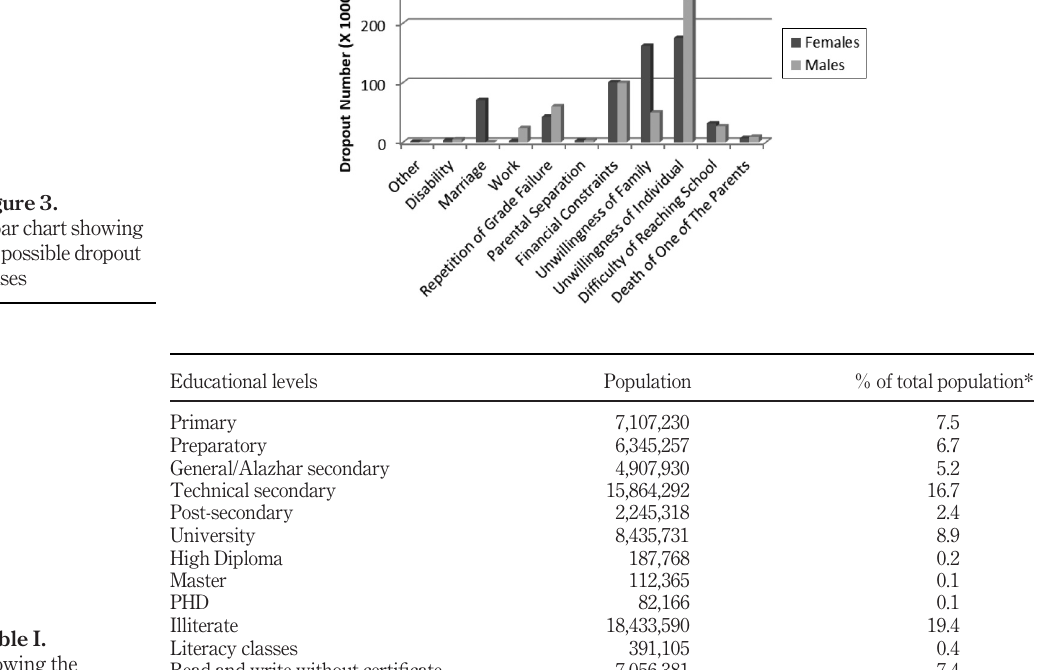
Table I. Showing